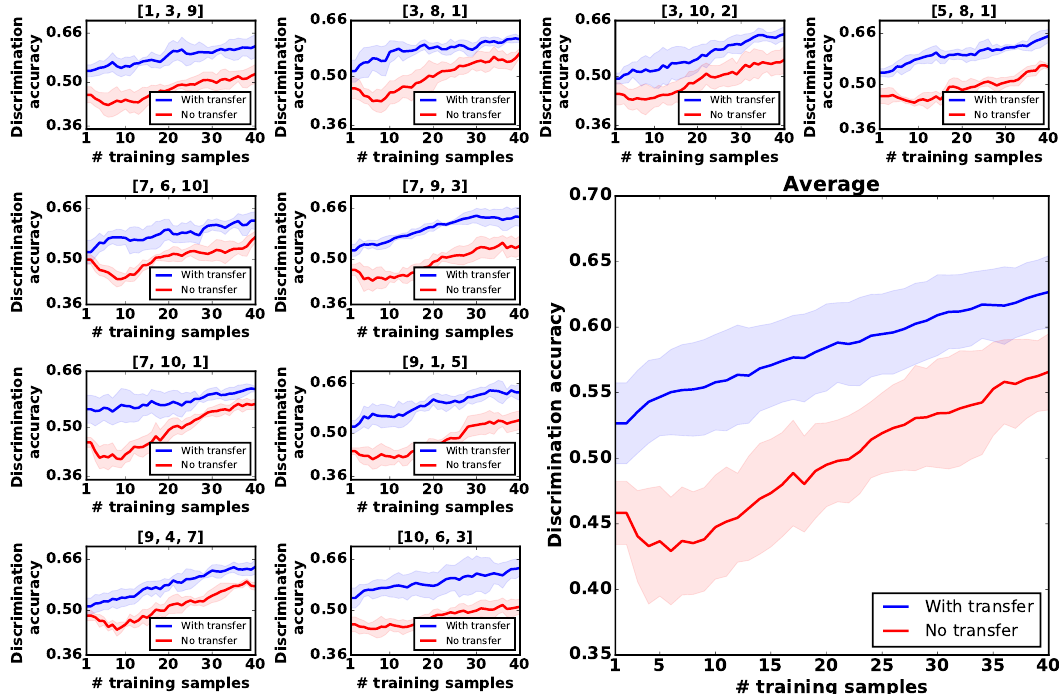
Figure 7. Transferring the exploratory actions experiences from three prior objects. The small plots show the learning process from 10 groups of old objects. The large plot on the right shows the averaged results. Horizontal axis: the growing number of feature observations the robot collected. Vertical axis: the discrimination accuracy of the test